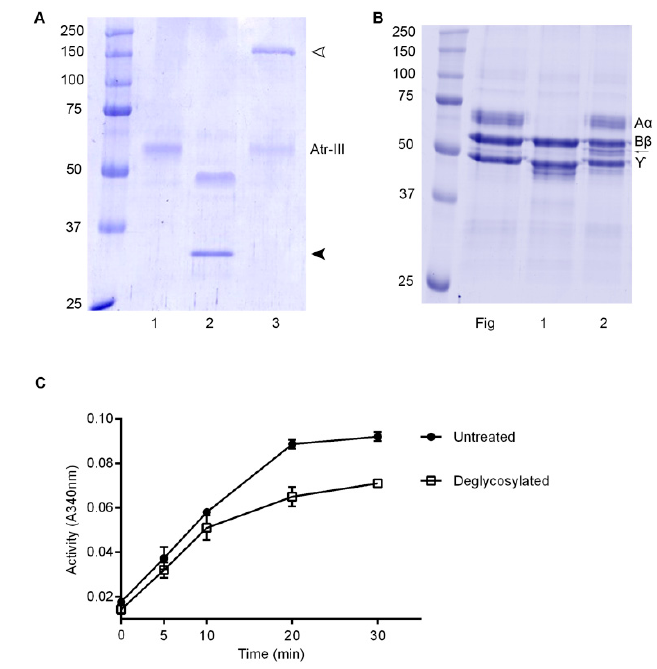
Figure 6. Deglycosylation of Atr-III. ( A ) SDS-PAGE (12% gel) of Atr-III untreated (1), or after treatment with PNGase F (2) or O-glycosidase (3), a band at ~35 kDa in lane 2 is an excess of PNGase F (indicated by a black arrow head) and a band at ~150 kDa is O-glycosidase (open arrow head). ( B ) Undigested fibrinogen (Fg), and Fg digested with Atr-III (1) or Fg treated with N-deglycosylated Atr-III (2). Molecular mass markers are shown in the left lanes of ( A ) and ( B ). ( C ) DMC hydrolysis by Atr-III (2 µg) without (- ● -) or with prior treatment with PNGase F (- □ -). Results are presented as SD ( n = 3). Note that loss of N-deglycosylation affected the venom enzyme activity.